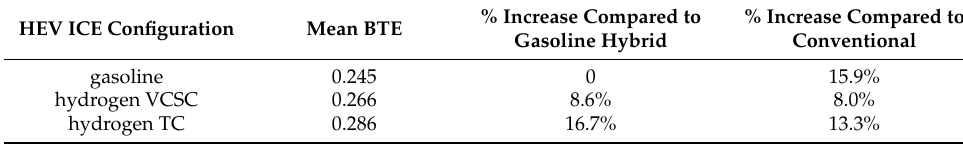
Table 4. The mean BTE of the three engine configurations in an HEV. HEV ICE